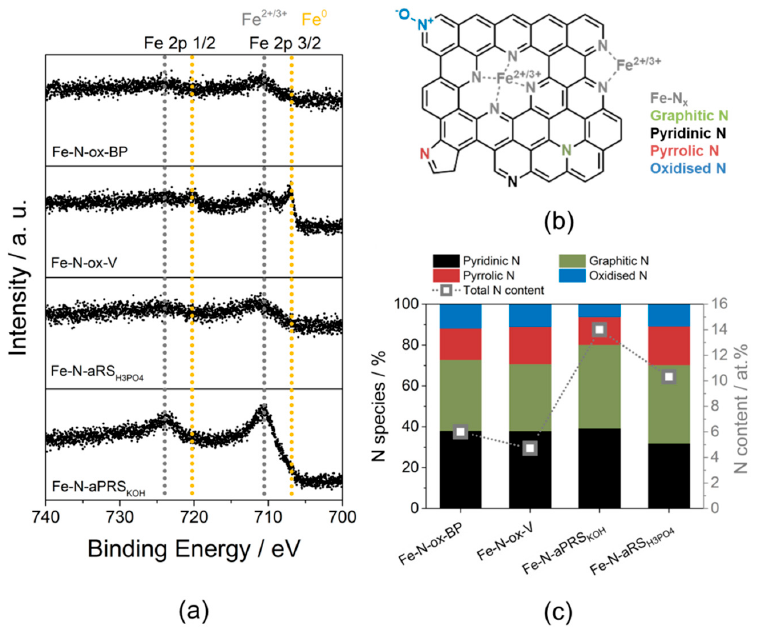
Figure 7. ( a ) Fe 2p XP-spectra of Fe-N-C materials; ( b ) the proposed structure of Fe-N-C material; and ( c ) ratios of nitrogen functionalities and total nitrogen content.